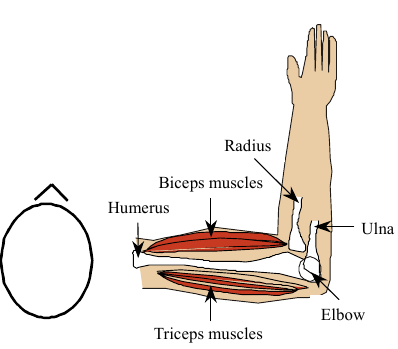
Fig. 4 Human arm biomechanical